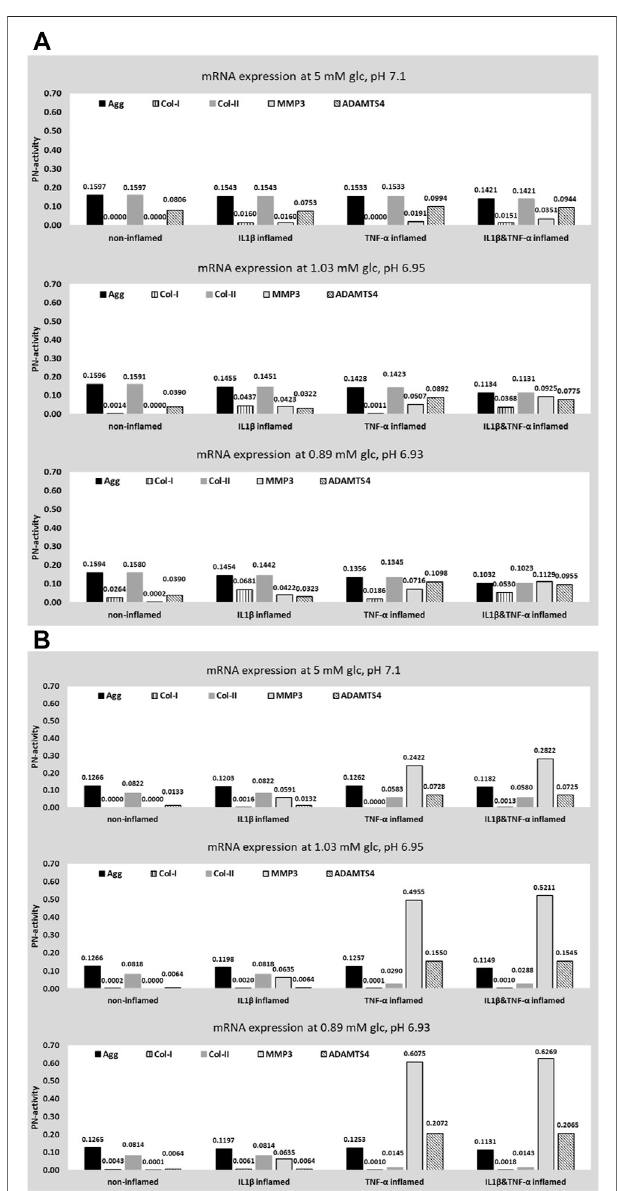
FIGURE 10 | Prediction of fi ve target mRNA expressions for four different proin fl ammatory cell states. Values were obtained for optimal, borderlineandearlydegenerated,nutritionalstimuluscombinations.Datawas obtained for two sets of weighting factors; an invariant weighting factor of 0.01 (A) and an individual weighting factor (B)